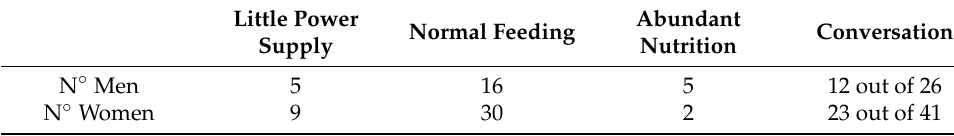
Table 3. Results of dossier n ◦ 2. Hairdresser Barber